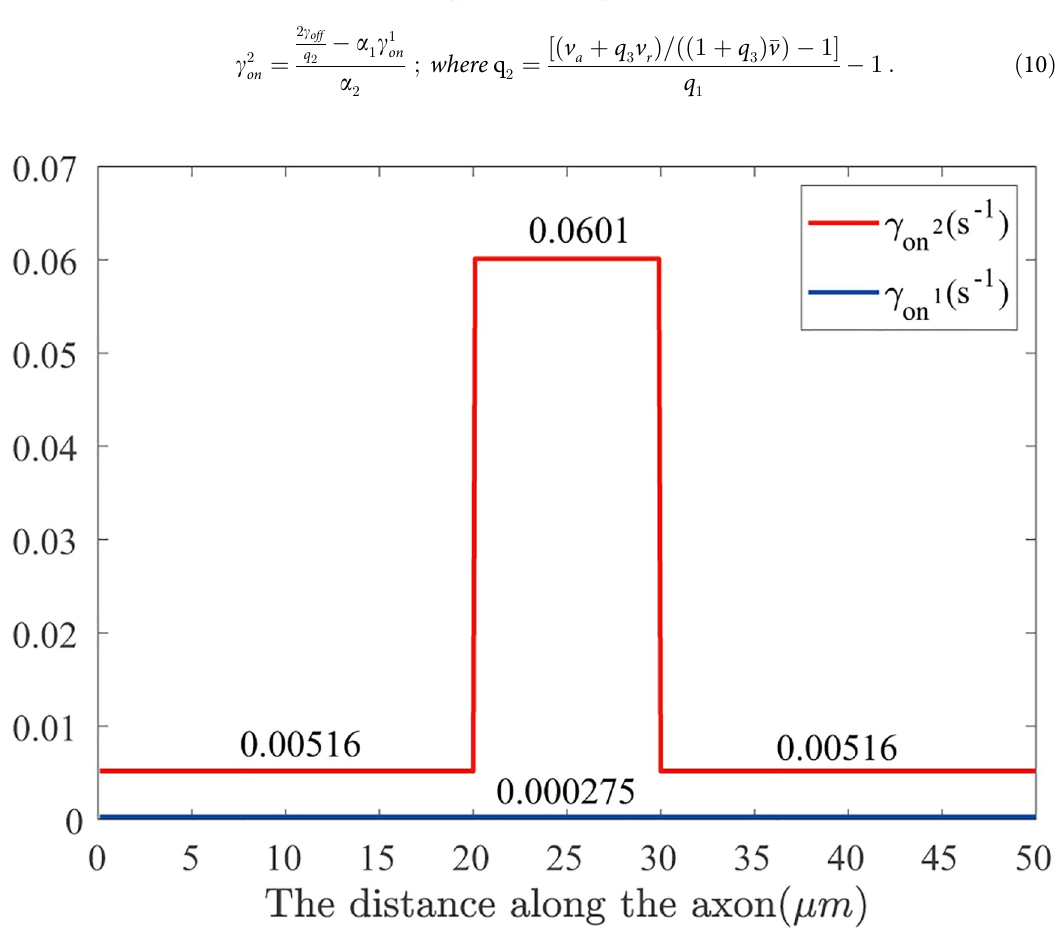
Fig 11. Distribution of on-track rates g 1